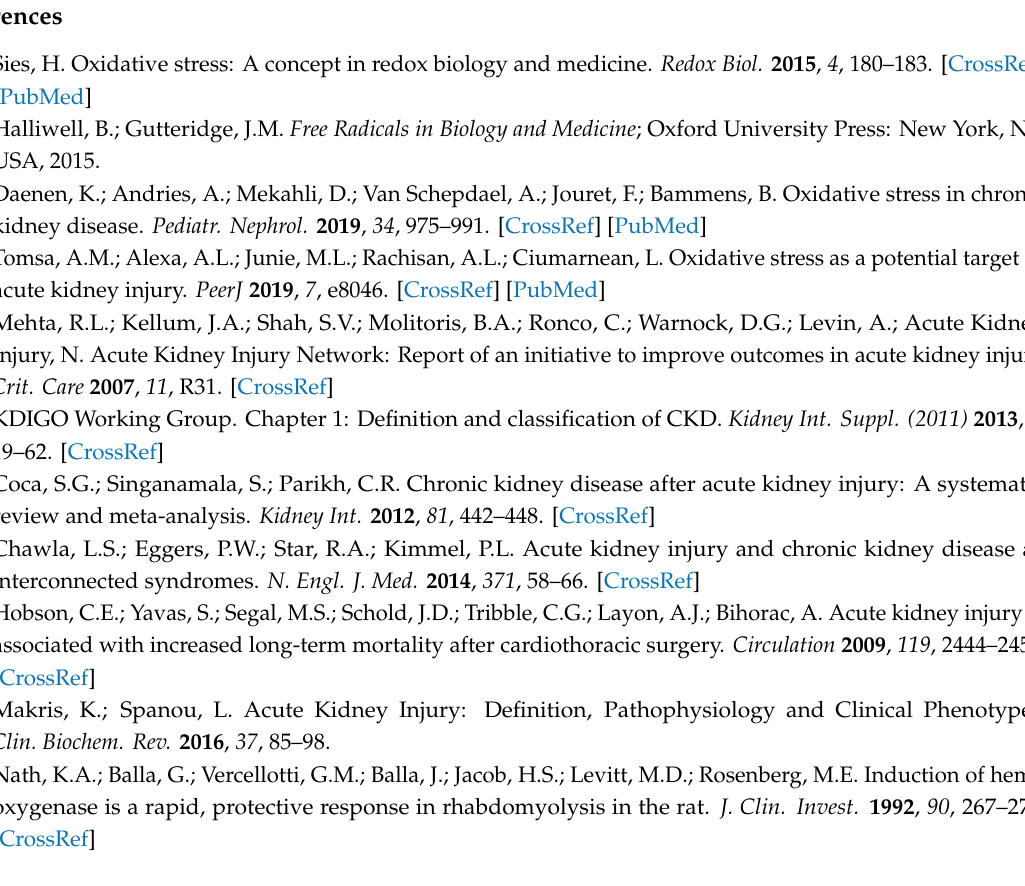
Figure S1: Uncropped western blots and densitometric calculation from Figure 2 (6 h), Figure S2: Uncropped western blots and densitometric calculation from Figure 2 (24 h), Figure S3: BCA results used for flux analysis normalization, Figure S4: Uncropped western blots and densitometric calculation from figure 4, Figure S5: Uptake of A1M in RPTE cells analyzed with